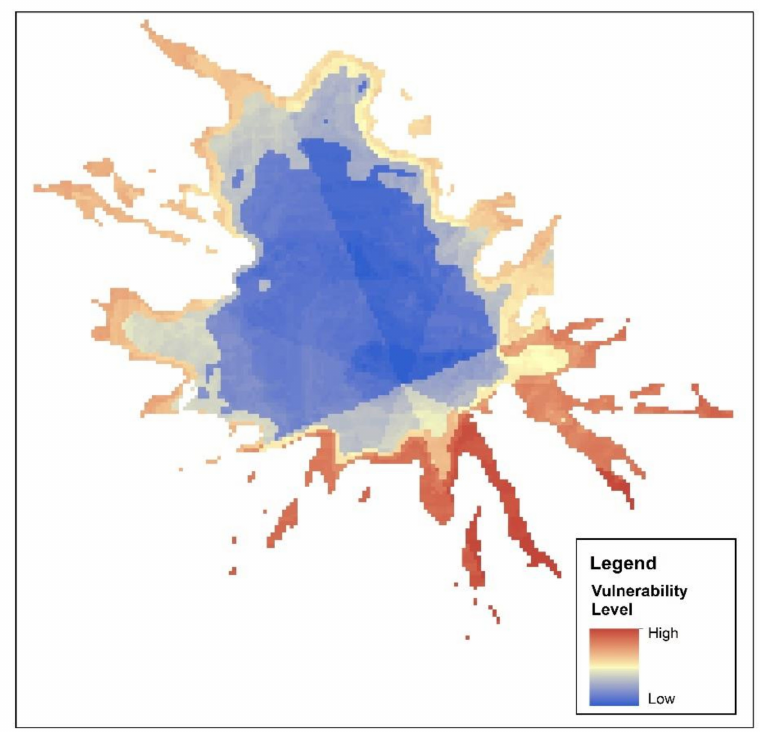
Figure 4. Glacier vulnerability